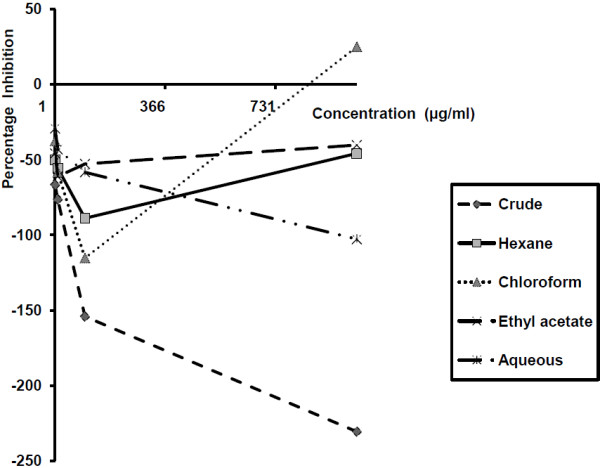
Percentage inhibition of monkey kidney cells lines maintained in culture for four days before exposure to Euphorbia hirta extracts for two days2. 2. Percentage inhibition of potassium cyanide (KCN) at 103 μg/ml = 52.8%; the optical density (OD) values for 1% DMSO (solvent control) = 0.109, cells cultured in plain culture medium = 0.149, and for heat killed cells = −0.037 (negative figures imply promotion of cell maintenance).